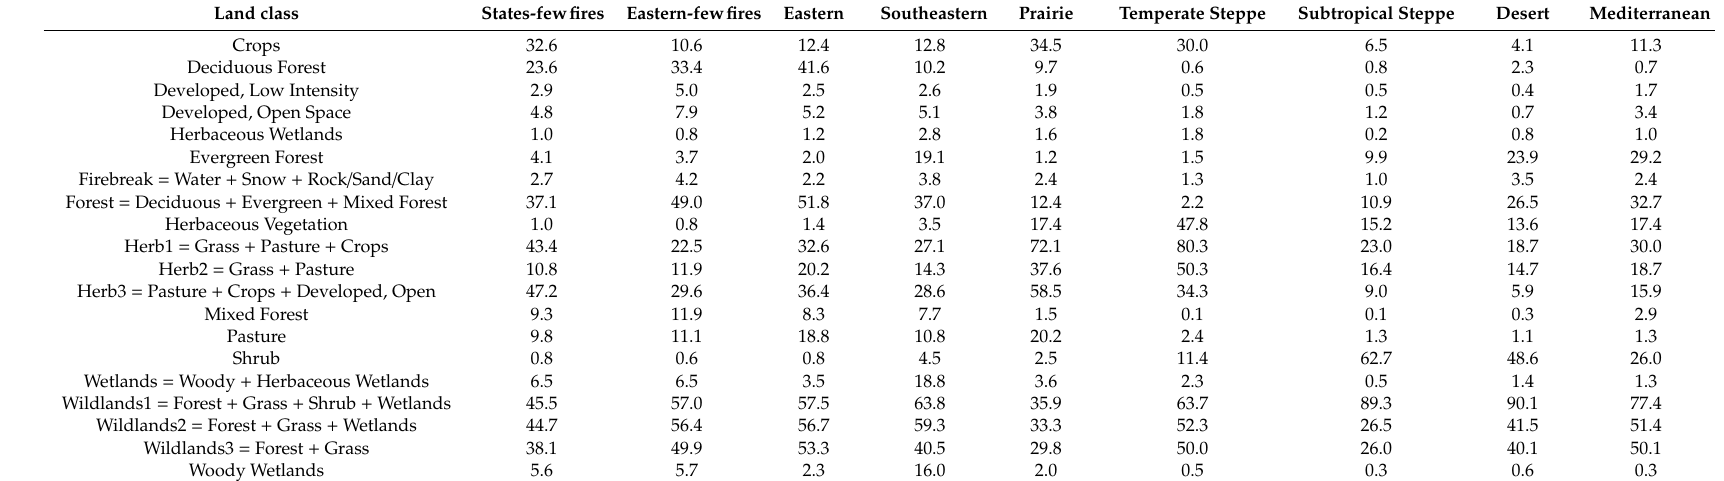
Table 2. Variables and values (% area) from the 2008 National Land Cover Database for 14 states with few fires, northeastern states with few fires in the eastern ecoregion, and ecoregions (years 1999–2017; ecoregions exclude 14 states with few fires).